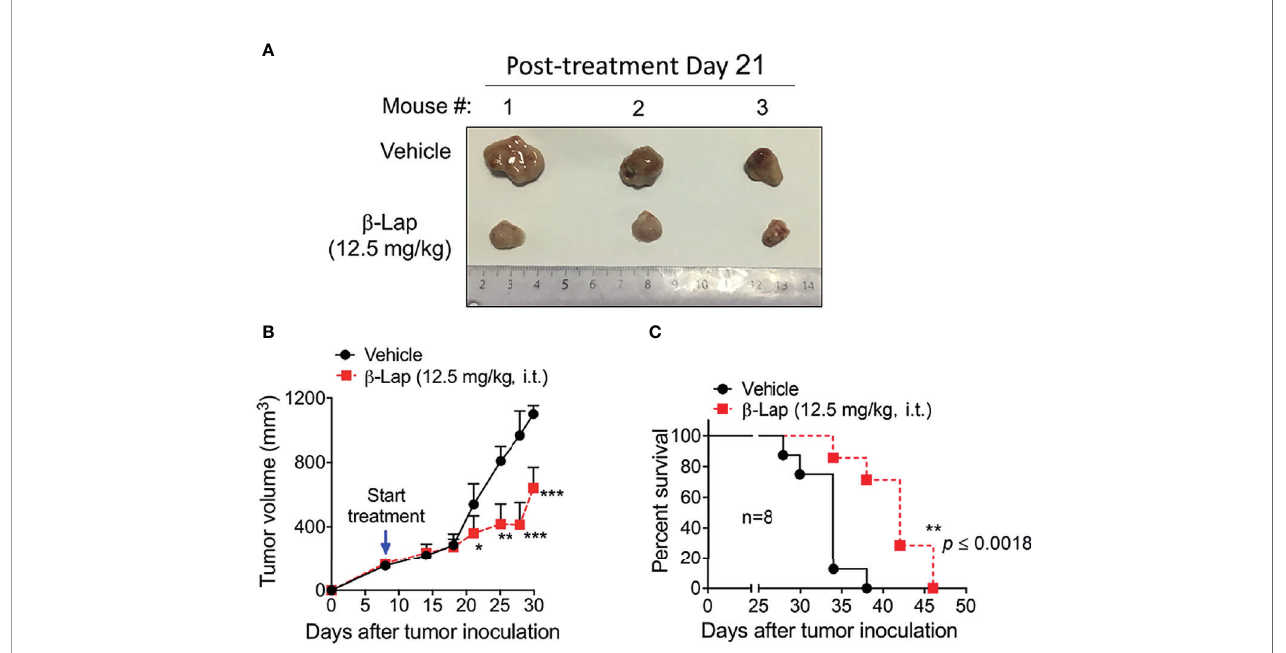
FIGURE 6 | Antitumor ef fi cacy of b -Lapachone in a mouse xenograft model. The subcutaneous xenograft tumor model was established by injection of 5×10 6 PLC/ PRF/5 cells into male NOD/SCID mice. After 8 days, mice were treated with vehicle (HP b CD) or HP b CD- b -Lap (12.5 mg/kg) by intratumor injections every other day for fi ve injections. (A) Representative tumors at day 21 post-treatment. (B) Tumor volume at the indicated time (days). (C) Kaplan-Meier survival curves. *** p < 0.001, ** p < 0.01, * p <